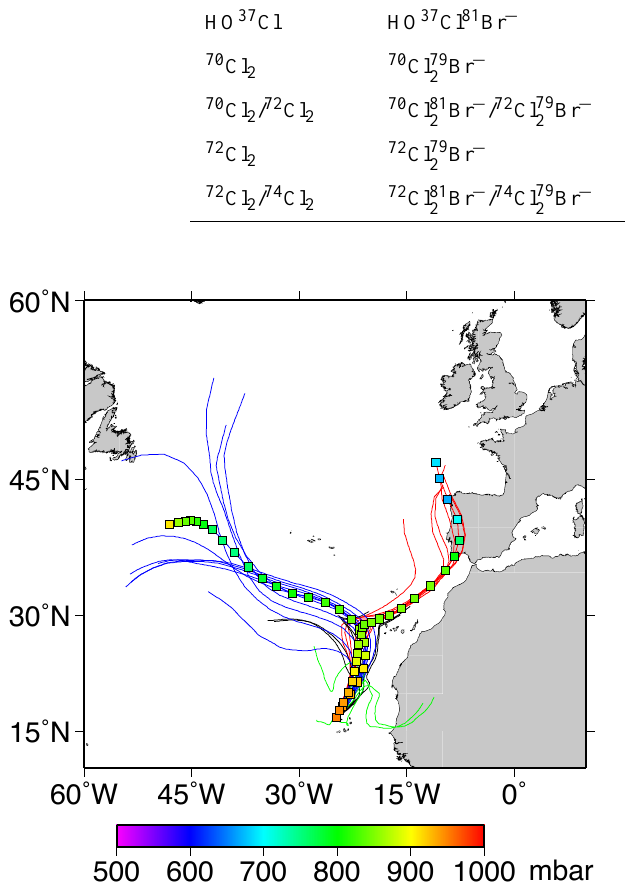
Fig. 1. 6-day back trajectories for air reaching the Cape Verde At- mospheric Observatory measurement site, given every 6h for all time periods that Cl 2 and HOCl were measured. Trajectory trace colors show different time periods by day of year (day 150.0 is